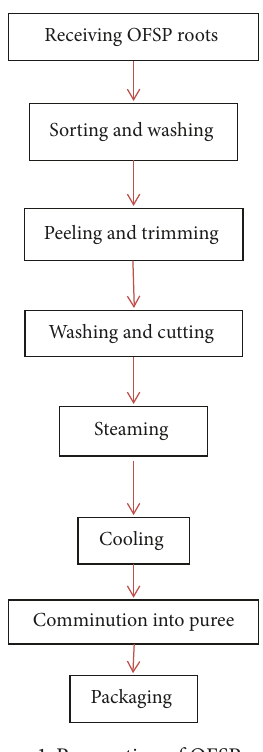
Figure 1: Preparation of OFSP puree.